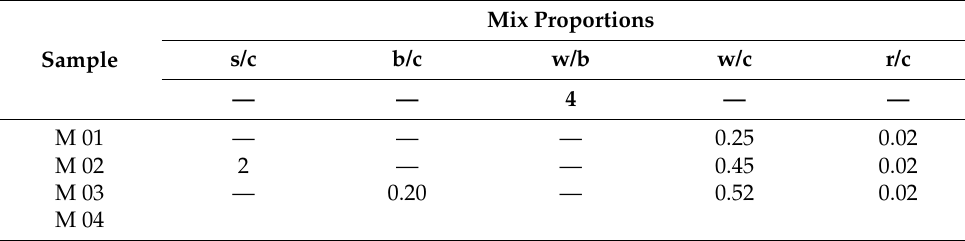
Table 3. Mix proportions for M 01, M 02, M 03 and M